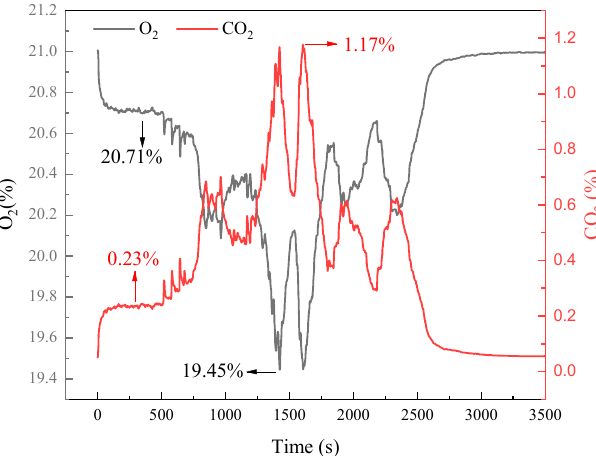
Figure 10. Concentrations of O 2 and CO 2 as a function of time during LIB pack combustion. Considerable research has been carried out to investigate the harmful gas generation of the TR process [21,31]. As shown in Figure 3, the batteries also generated a large amount of smoke during the combustion or TR process, which was overlooked in previous studies. The electrolytes and active materials inside the battery were burned, carbonized, and erupted, which was the main reason for smoke release. SPR is one of the critical parameters for characterizing the smoke-releasing process. By integrating the SPR curve, TSP was calculated. Their curves are shown in Figure 11. The SPR curve contained five peaks, of which the values were 0.6, 1.9, 1.9, 1.9, and 2.3 m 2 /s, respectively. The peaks of SPR corresponded to the peaks of HRR. At the initial combustion stage, smoke diffused in the space to form a small SPR peak. With the increase in HRR, SPR continuously increased. However, the flame strength was not the only reason for the rise in SPR. The highest value of SPR appeared at the fifth peak position, mainly caused by TR propagation. Due to heat dissipation in the process of TR propagation, the LFP battery combusted incompletely, which caused an increase in SPR [8,32,33]. After the combustion of the LIB pack, the space was still filled with a large amount of smoke and the SPR value was 1.5 m 2 /s. At 4000 s, the value of TSP reached 4074 m 2 .